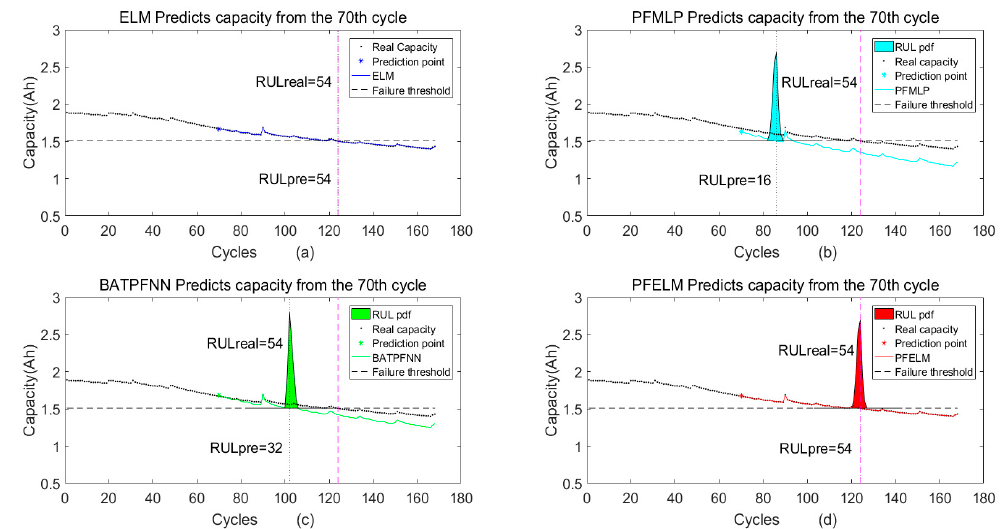
Figure 20. Predicting capacity from the 50th cycle by different algorithms: ( a ) ELM ; ( b ) PFMLP; ( c ) BATPFNN; ( d ) PFELM.